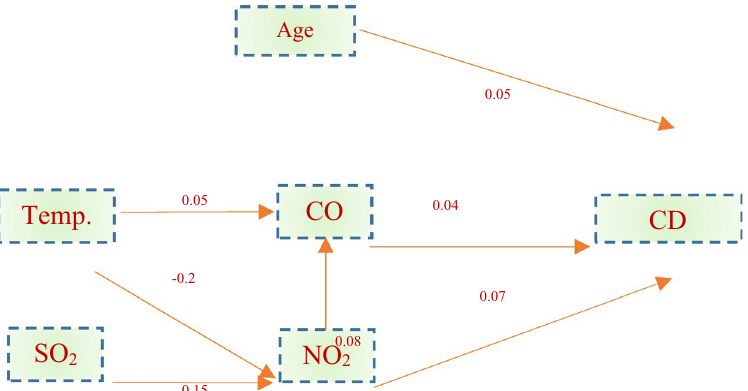
Figure 4. The relationship between index pollutants and the number of CD patients admitted in the hospital using multivariate linear